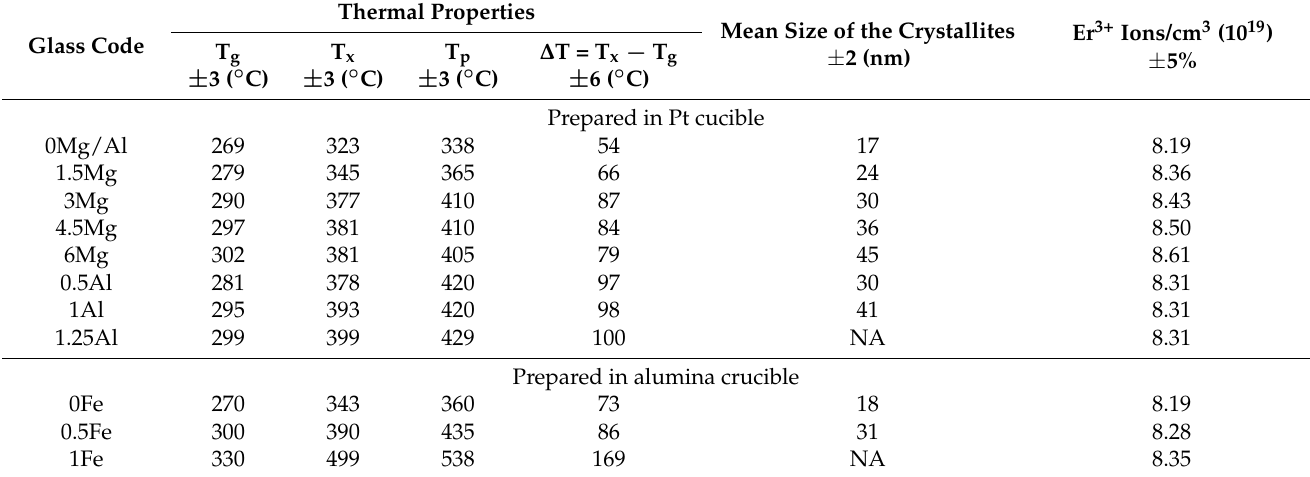
Table 2. Thermal properties of the investigated glasses (NA: the peak intensity is too small to estimate the size of the crystallite)